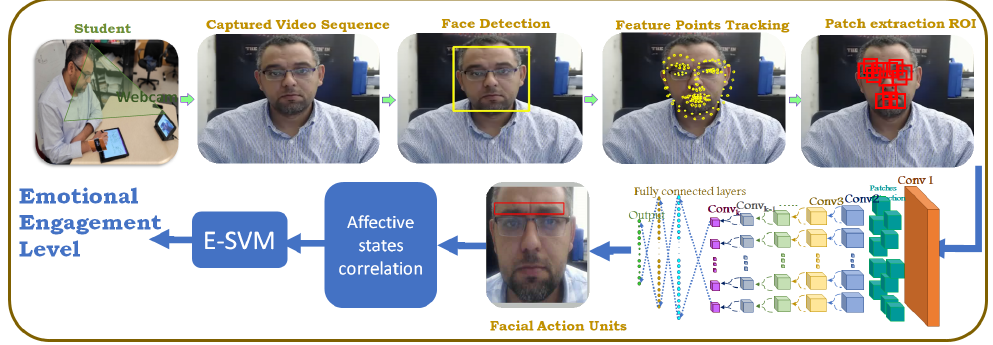
Figure 4. The proposed emotional engagement